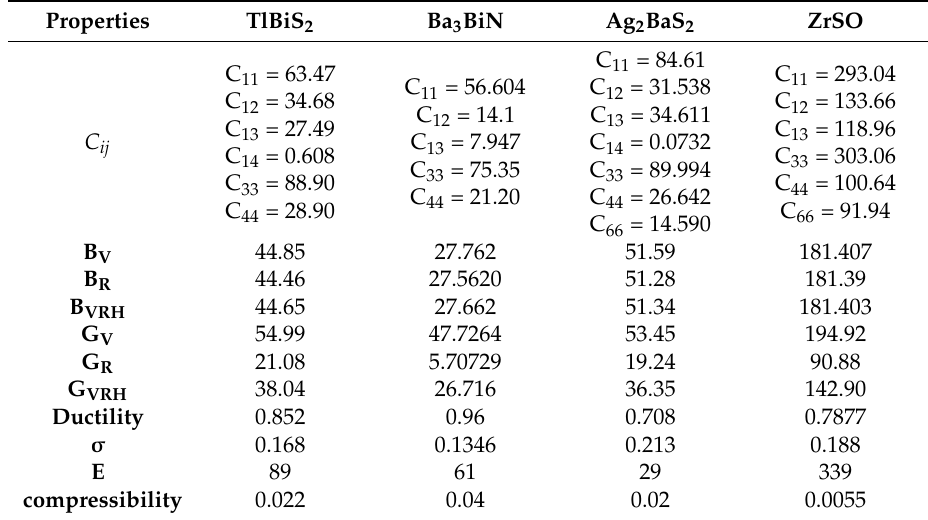
Table 4. The calculated single-crystal elastic constants C ij (in GPa), bulk modulus B (in GPa), shear modulus G (in GPa), Poisson’s ratio ( σ ), Young’s modulus E (in GPa), compressibility (GPa − 1 ), Ductility for TlBiS 2 , Ba 3 BiN, Ag 2 BaS 2 and ZrSO phases. Subscript V illustrates the Voigt bound, R indicates the Reuss bound and VRH indicates the Hill